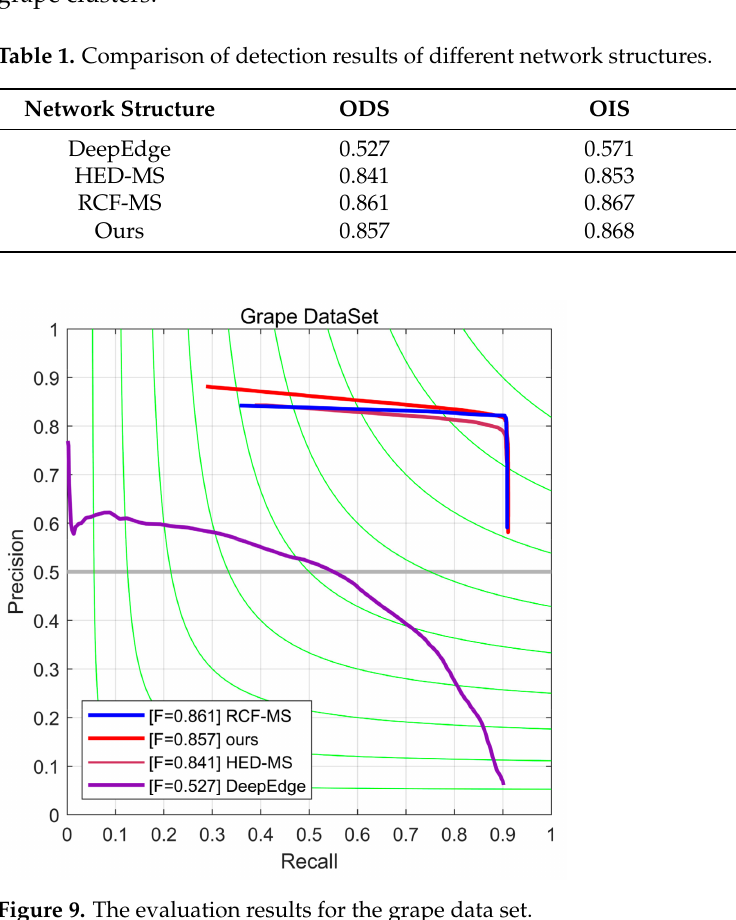
Figure 9. The evaluation results for the grape data